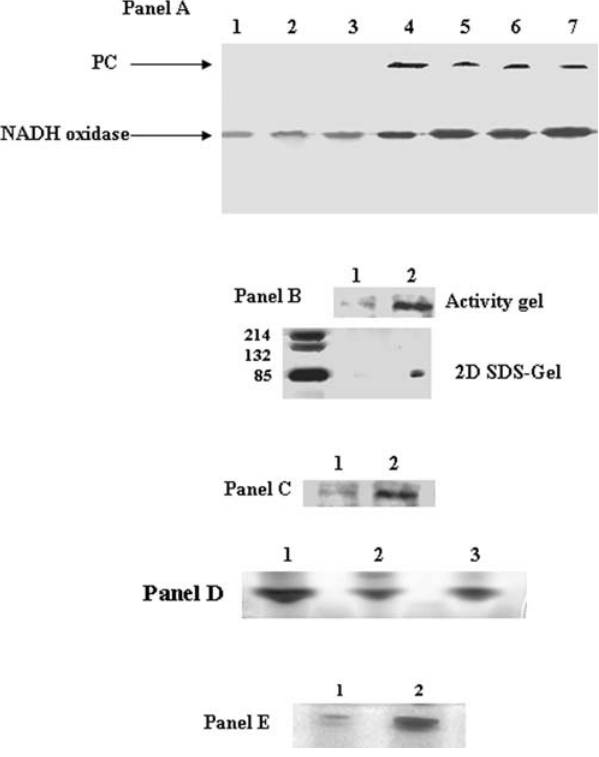
Figure 3. Determination of PC, PEPCK, and PK activity and expression in control and menadione-stressed cells. Panel A ) In-gel detection of PC activity. Lanes 1, 2, and 3 correspond to membrane CFE from cells grown in control media for 15, 24, and 30 hrs. Lanes 4, 5, 6, and 7 correspond to membrane CFE from cells grown in menadione-stressed media for 25, 30, 35, and 40 hrs. Panel B ) 2D SDS- PAGE analysis of PC expression. In-gel activity bands were excised and resolved by 2D SDS-PAGE to determine protein levels. Lane 1 and 2 correspond to control and menadione-stress cultures. Proteins were detected by silver staining. Panel C ) Immunoblot analysis of PC expression. Lane 1 and 2 correspond to the control and menadione- stress cultures. Panel D ) Regulation of PEPCK activity. Lane 1, 2, and 3 correspond to soluble control CFE, soluble menadione-stress CFE, and soluble CFE of control cells transferred into a menadione-stress media. Panel E ) In-gel activity analysis of PK. Lane 1 : corresponds to control and Lane 2 : corresponds to menadione-stressed soluble CFE. Cells were isolated at similar growth phases (25 h for control and 30 h for menadione) unless otherwise